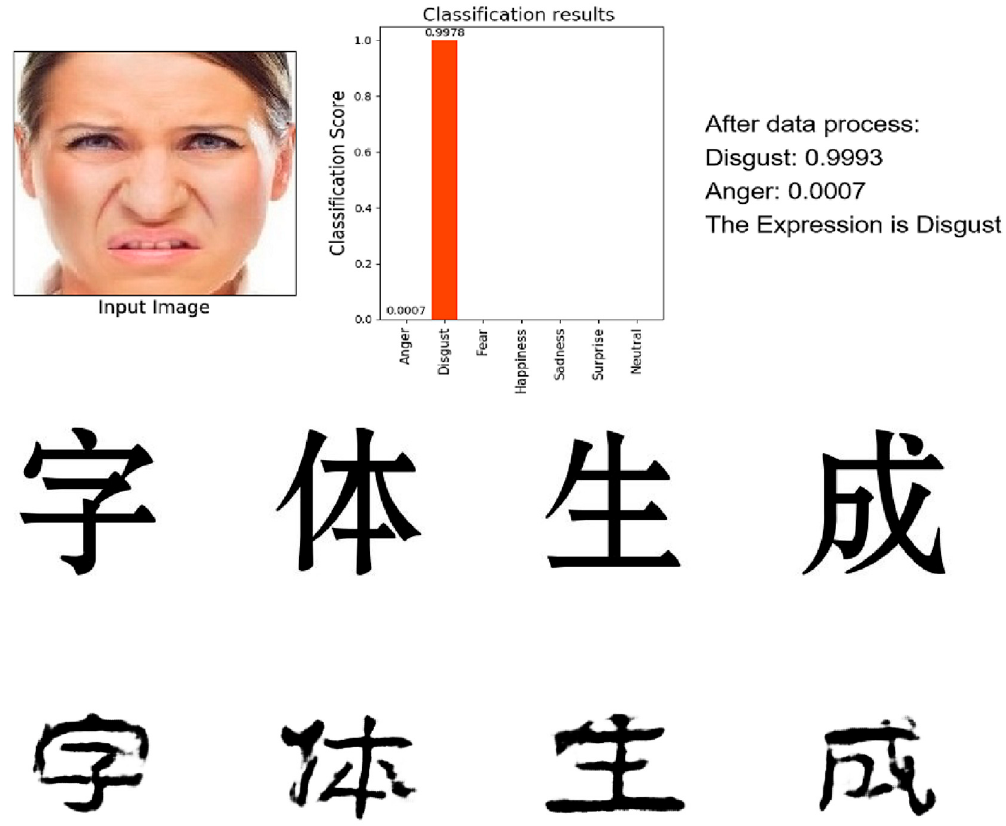
Figure 8. The results of expression recognition and the generated font with corresponding emotions. When inputting a facial image with specific emotions, a new font is generated by combining the first two probabilities of the emotions.